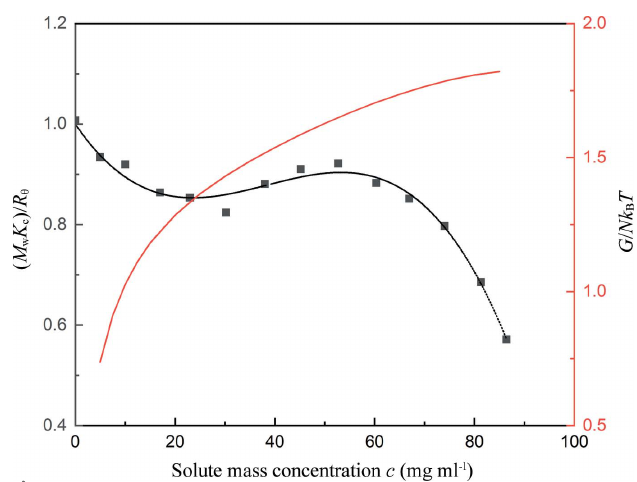
Figure 1 Kc = R Debye plot of the M ratio as a function of OTBN mass (cid:3) w concentration. Black line: fit of osmotic virial expansion to data. Red line: evaluation of the free-energy density of OTBN–methanol solution according to equation